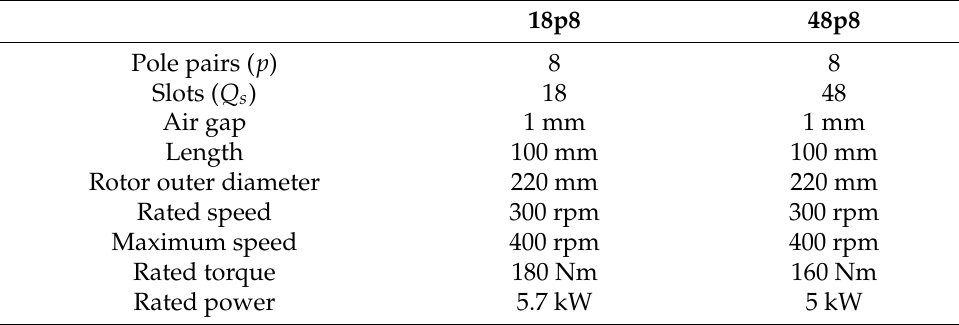
Table 2. Characteristics of the electric motors 18p8 and